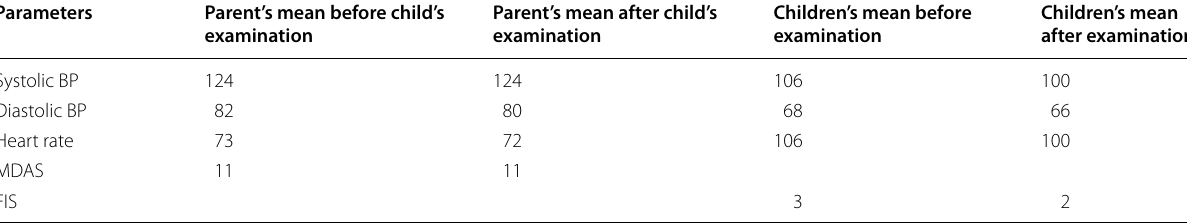
Table 4 Comparative evaluation of parameters of parents and children during the first visit